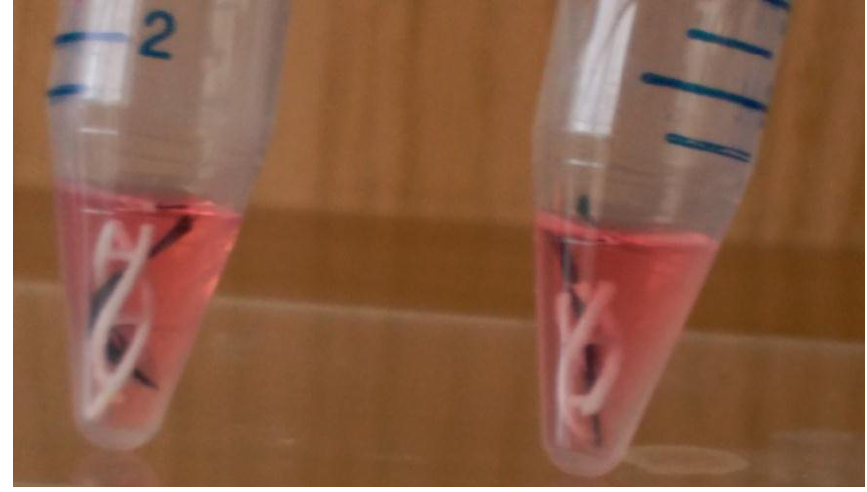
Figure 3. 3D-printed lattices with embedded–knitted carbon fibers during the cell culture process.